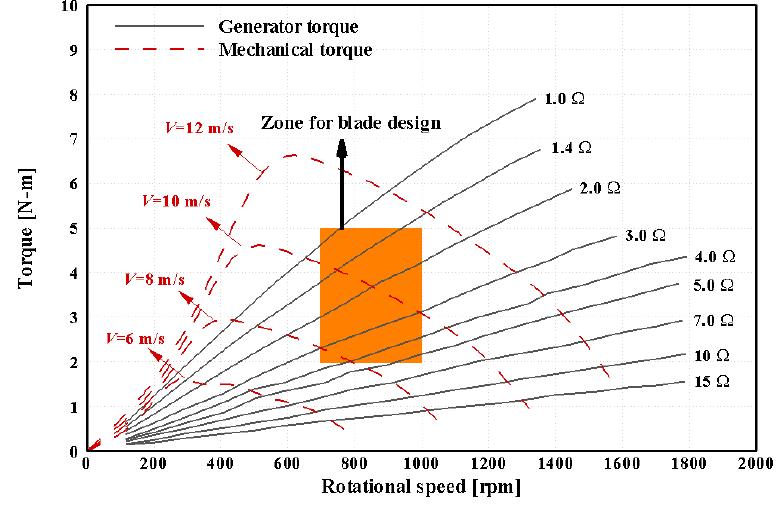
Figure 14. Distributions of ( a ) torque and ( b ) power between the generator and mechanical results at different rotational